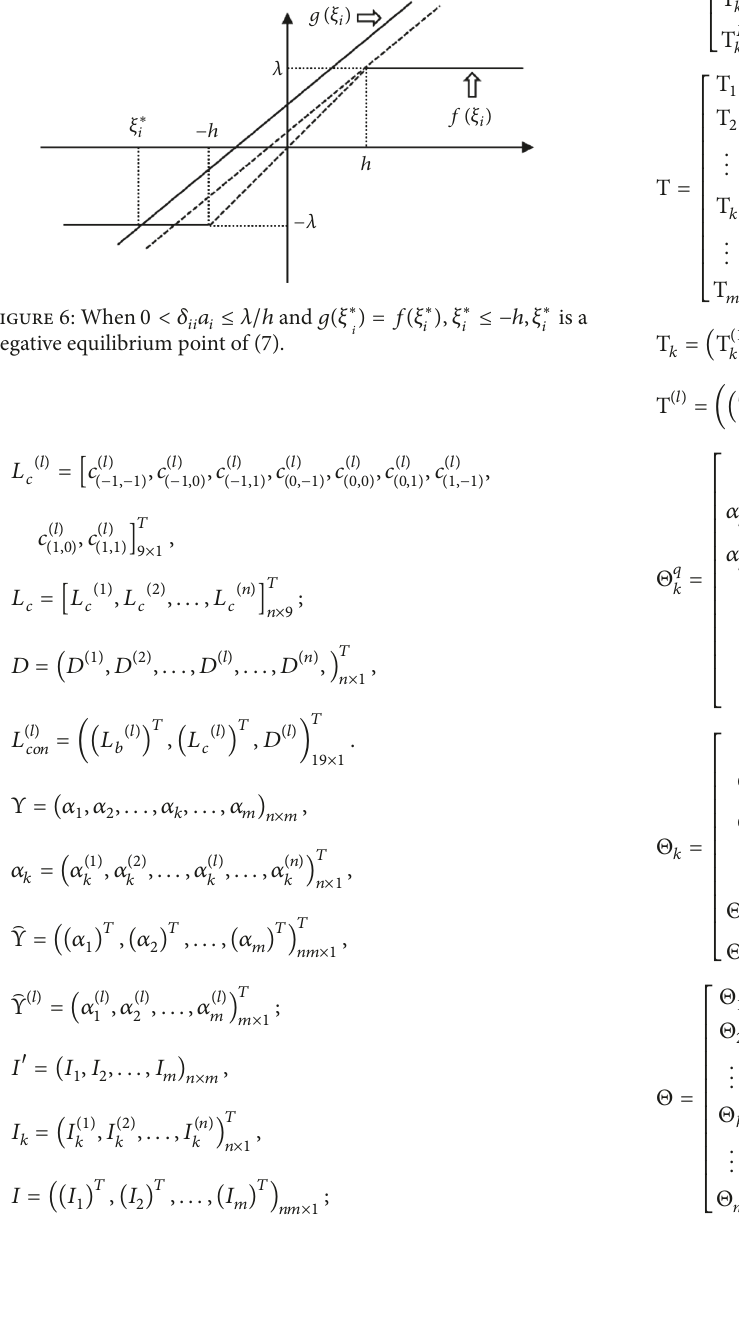
Figure 5: When 0 < 𝛿 𝑖𝑖 𝑎 𝑖 ≤ 𝜆/ℎ and 𝑔(𝜉 ∗ positive equilibrium point of (7).